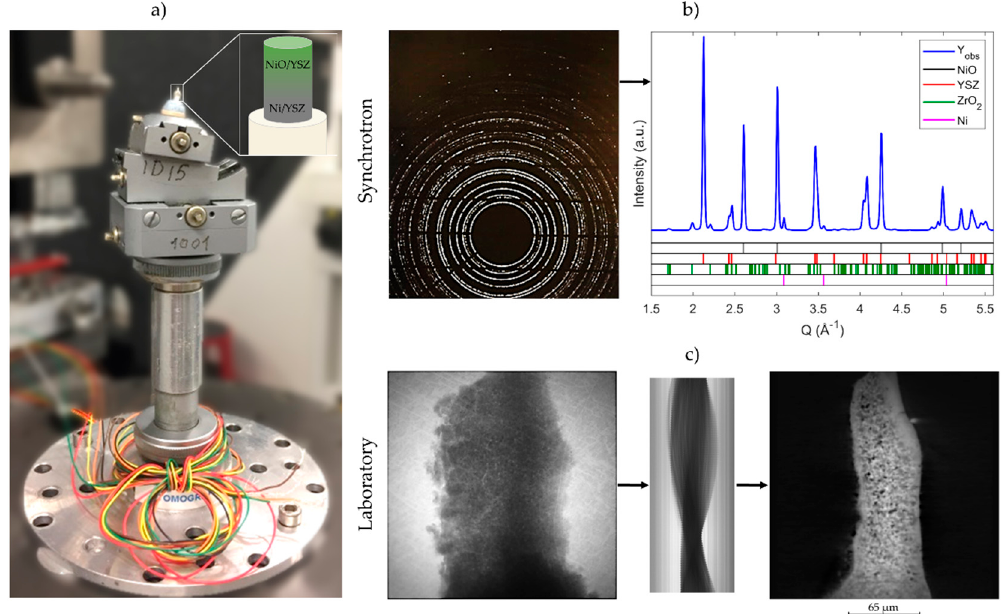
Figure 1. X-ray analysis of the partially oxidized solid oxide fuel cell (SOFC) anode sample. ( a ) The SOFC sample; ( b ) synchrotron method XRD and XRD-CT, from diffraction ring to integrated pattern; ( c ) laboratory method nano-CT, from radiograph to reconstructed ortho-slice.